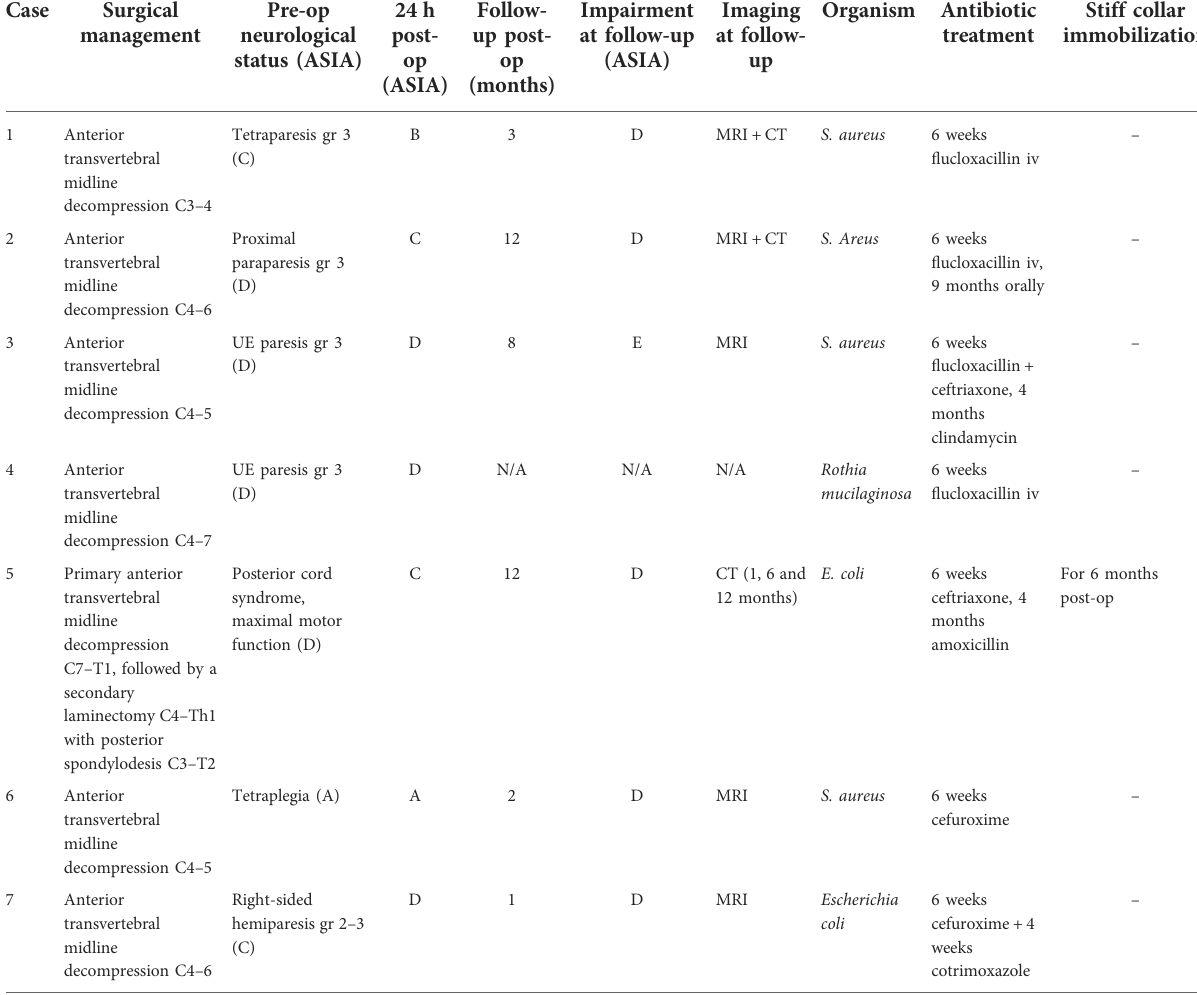
TABLE 2 Overview of surgical and antibiotic management, peri-procedural neurological